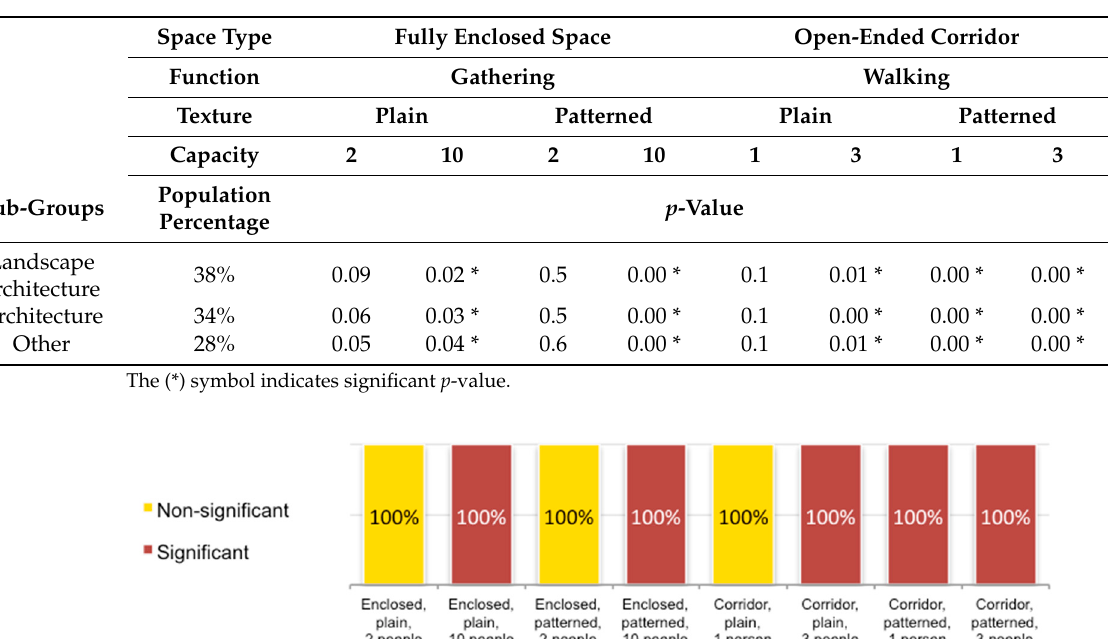
Table 6. Professional design experience perception filter and comparisons of space size variations between IVRIE and DT systems.